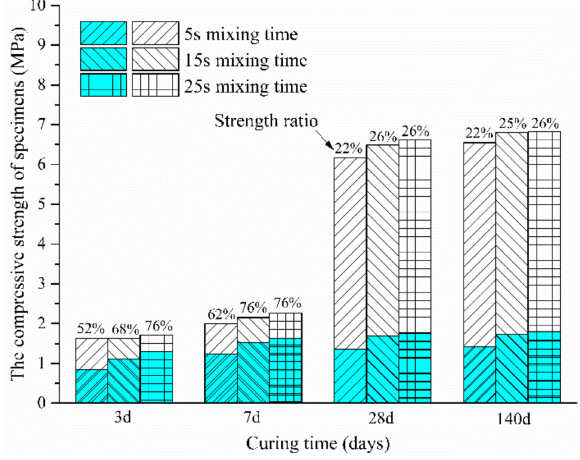
Figure 8. Compressive strengths of CSG consolidation formed in water and air with different initial mixing time.